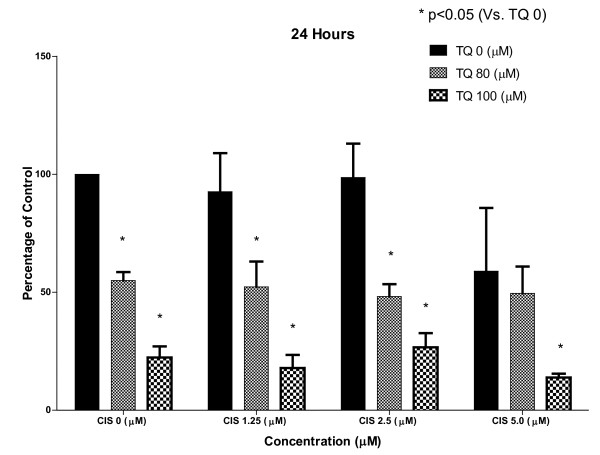
The figure shows results of MTT assay for cell proliferation using NSCLC cell line NCI-H460 at 24, 48 and 72 hrs with control group representing 100% cell proliferation depicted by extreme left solid line. TQ alone is more active at 24 hrs and CDDP more active at 48 and 72 hrs. The combination of TQ and CDDP is more active than each agent alone with up to 89% inhibition of cell proliferation at 72 hrs with combination of TQ 100 μM and CDDP 5 μM. (*) shows significant inhibition by TQ at each level of CDDP (p < 0.05).